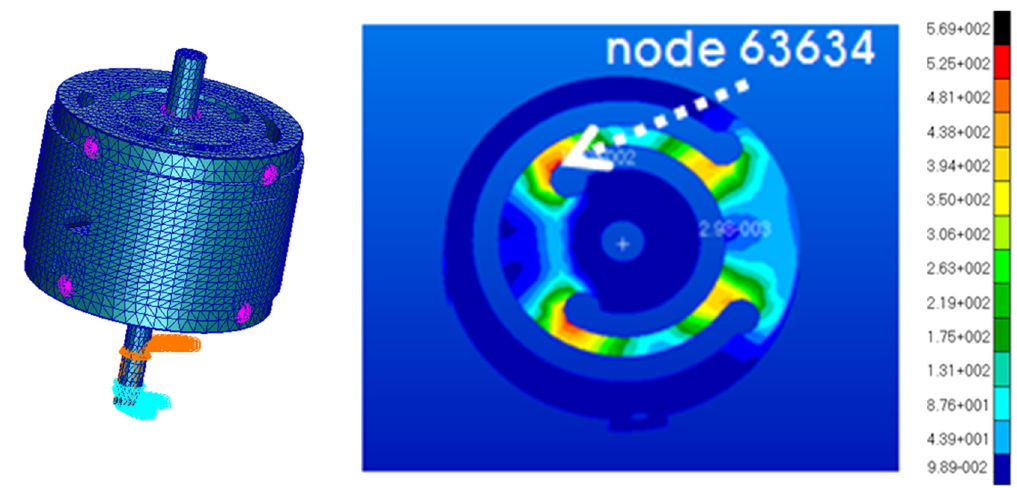
Figure 8. The finite element analysis (FEA) model of the VEH device and the stress distribution on the spring.